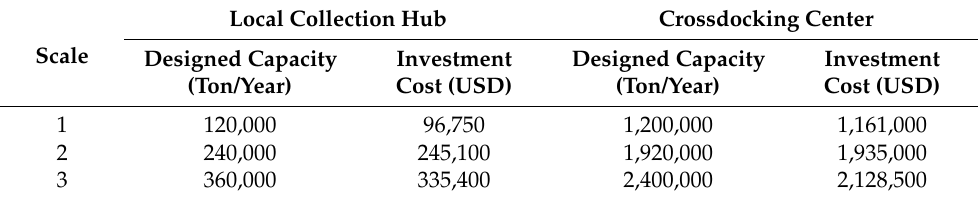
Table 7. Facility capacity and investment cost.